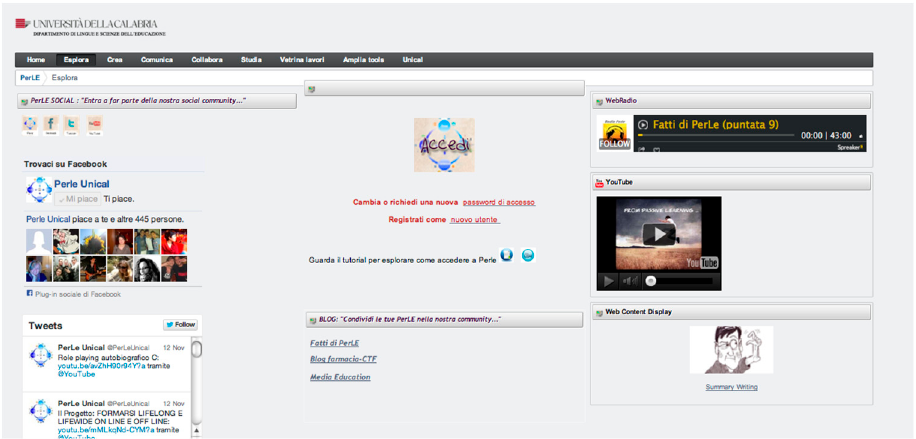
Figure 1. The PerLE homepage.